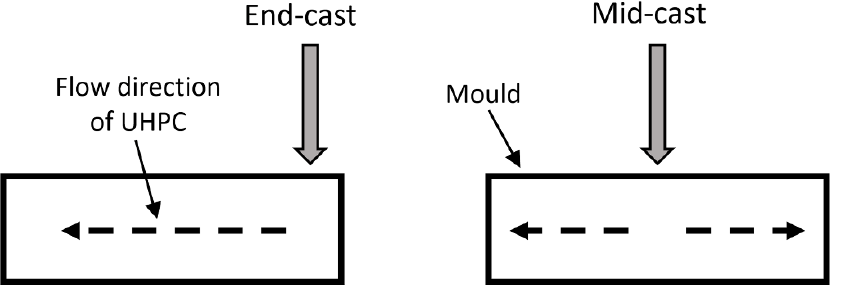
Figure 1. Schematic of casting at two different positions. Left: end casting (end-cast); right: middle casting